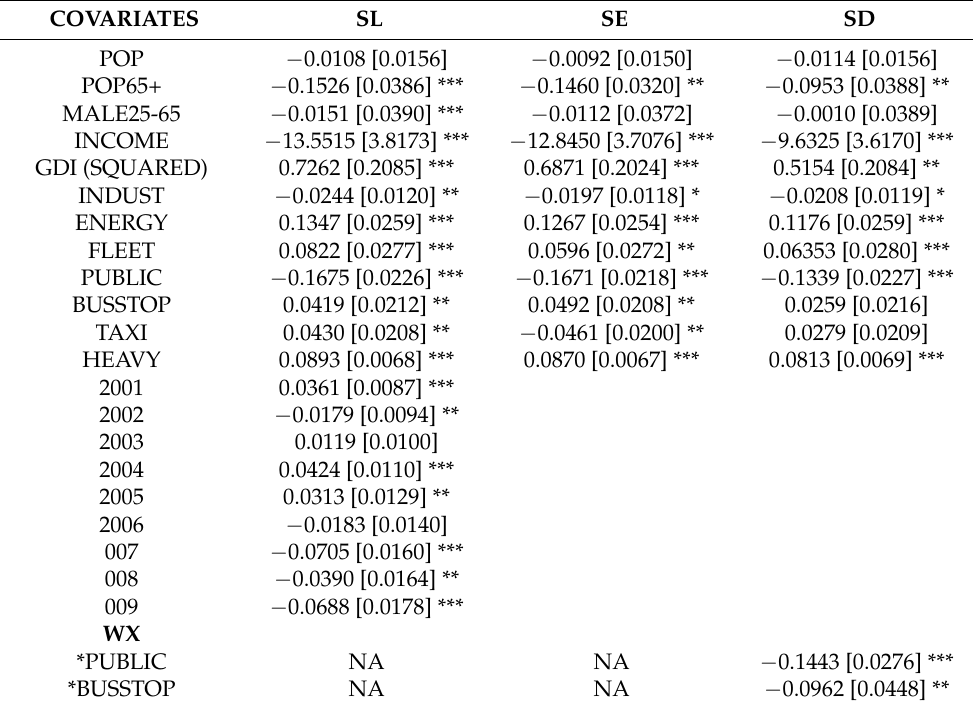
Table A1. Estimates of coefficients for Spatial-PD-STIRPAT models (Fixed Effects).